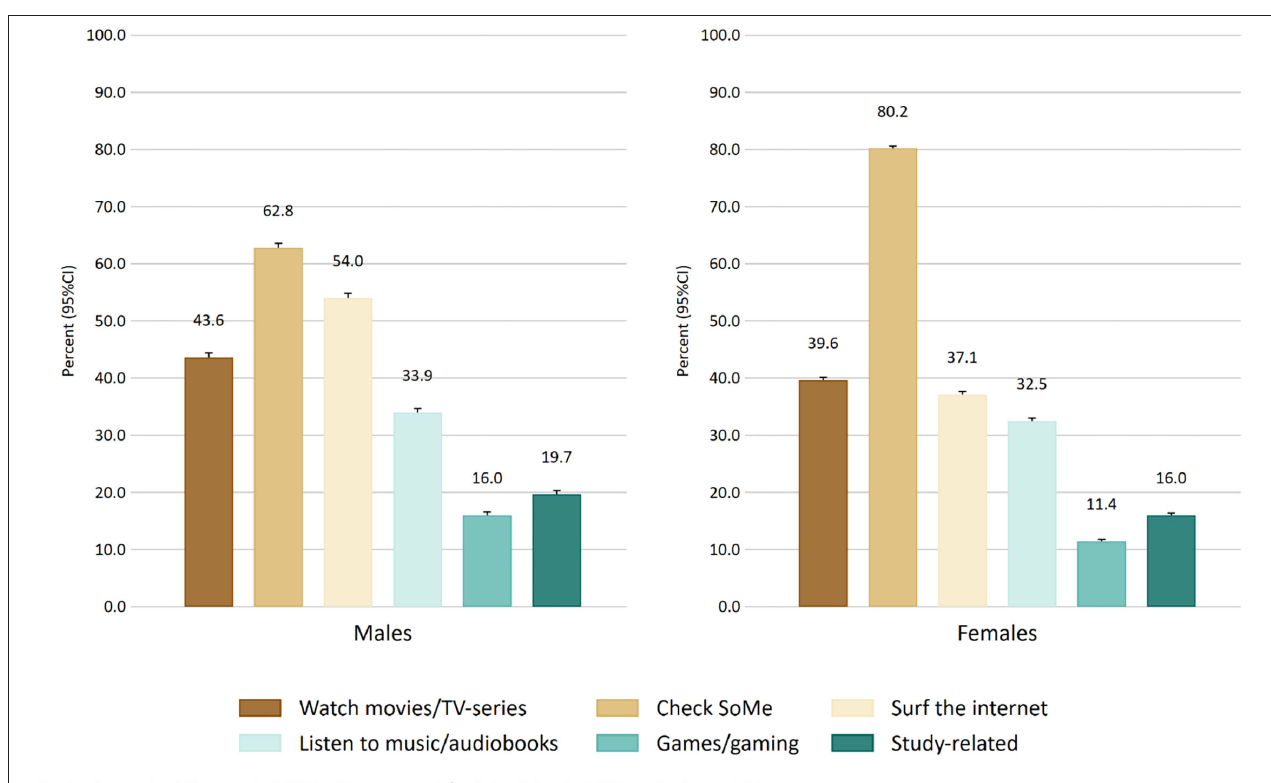
FIGURE 1 | The prevalence of screen-based behaviors in the evening across males and females.